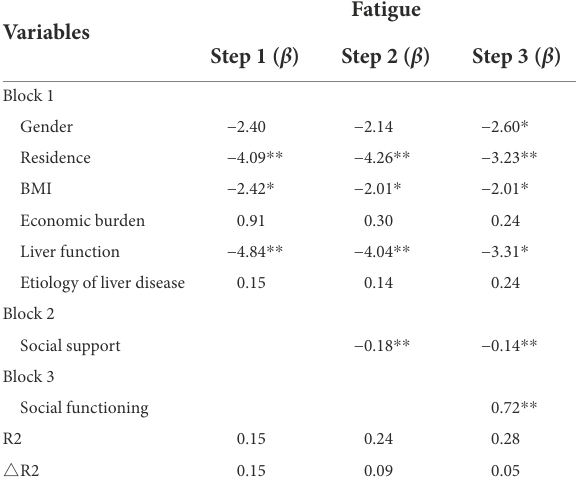
TABLE 3 Hierarchical multiple linear regression analysis results.